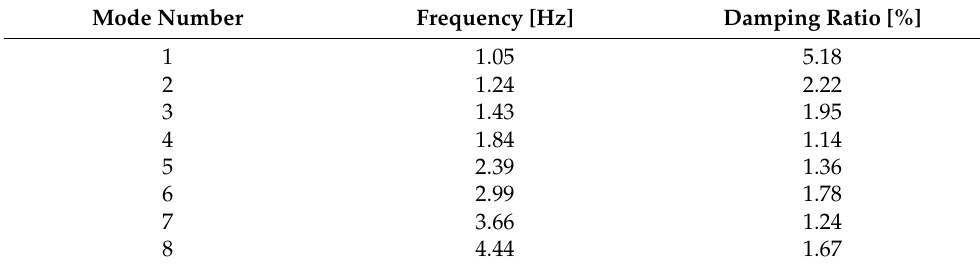
Table 2. Natural frequencies and damping ratios for the B2